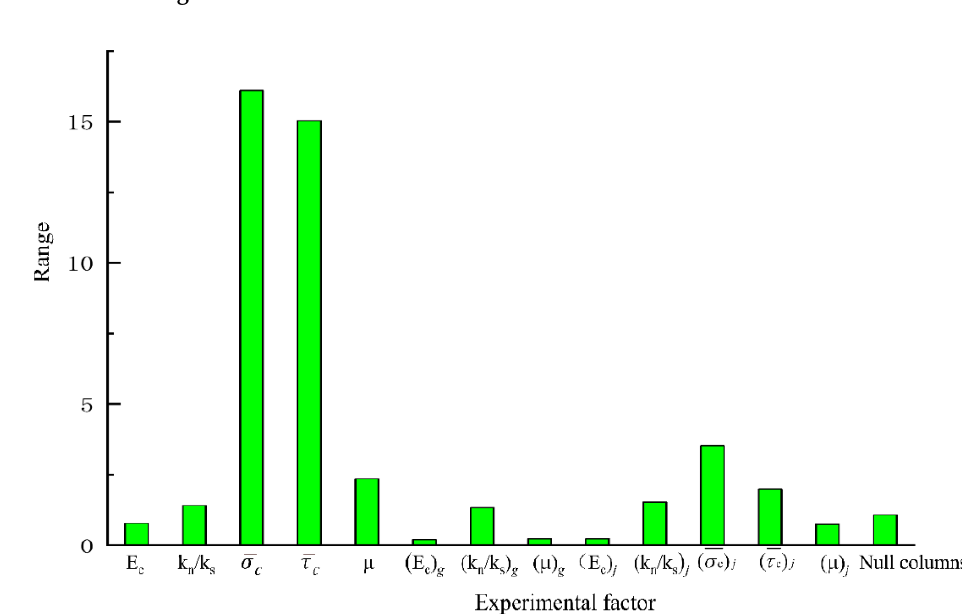
Figure 8. Results of analysis of range of peak intensity.